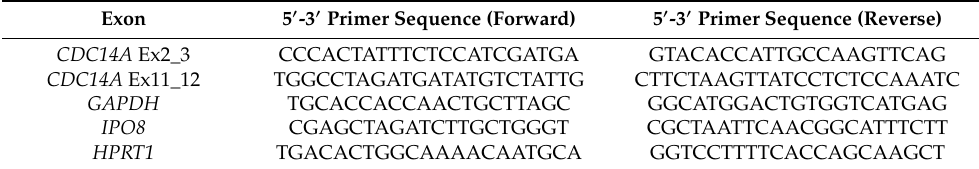
Table 2. Primer sequences for